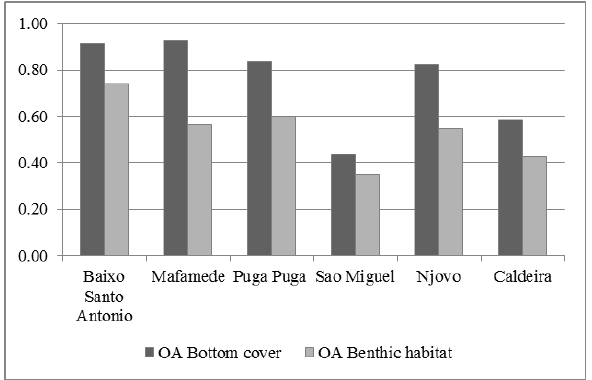
Figure 3. Overall accuracy (OA) results at bottom cover (L2) and benthic habitat (L3) levels.